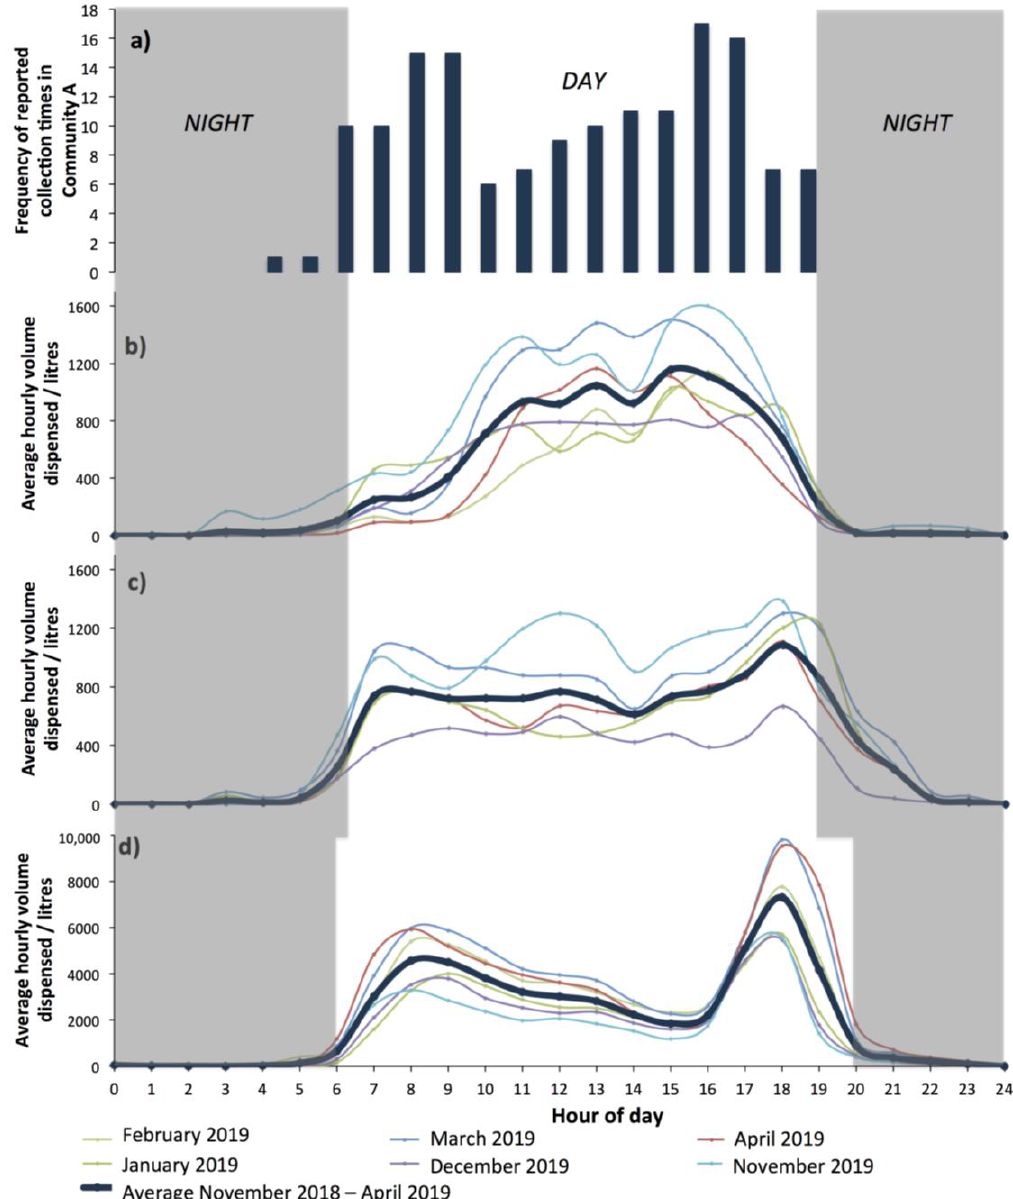
Figure 2. ( a ) Cumulative frequency distribution of reported collection times of households in Community A; ( b ) Usage data of combined average hourly use from all DPs in Community A for the period November 2018–April 2019; ( c ) Community A2; and ( d ) Community B.